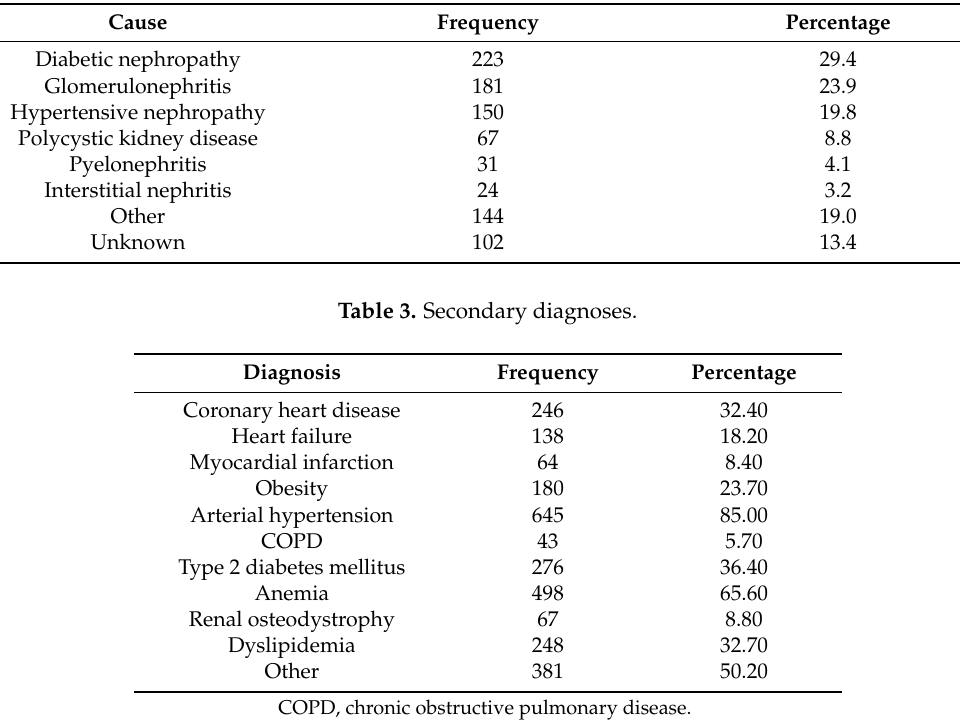
Table 4. Predialysis population at study start: CKD Stages and Attainment of iPTH Targets.